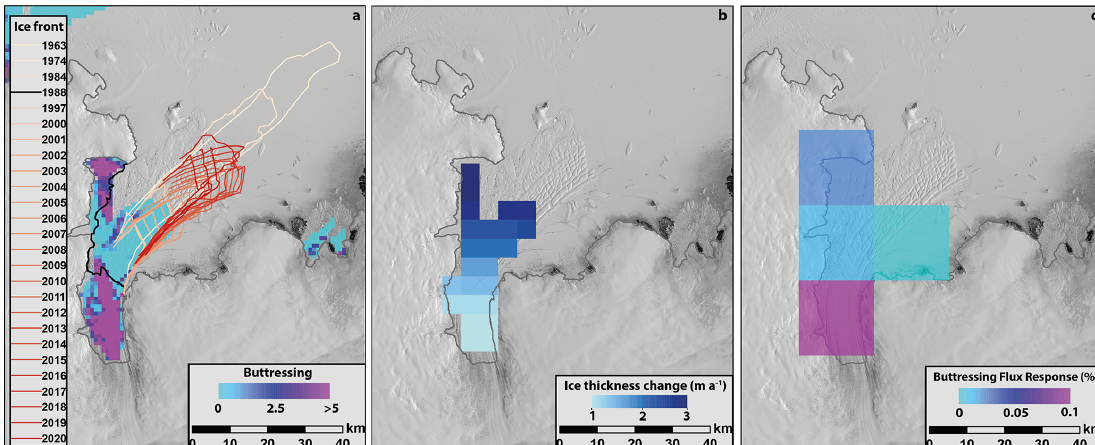
Figure 5. (a) Simulated maximum buttressing potential of the Shirase ice tongue (Durand et al., 2016). Light blues mean the ice is passive, and purples mean the floating ice is dynamically important. Note how the ice tongue conglomerate is not important for buttressing, but parts of the inner shelf are important. No dynamically important ice has calved over the past 57 years. (b) Ice tongue thickness change between 2003 and 2019 showing thickening of the Shirase ice tongue (Smith et al., 2020). (c) Simulated response of ice flux to thinning of floating ice in each grid cell by 1m (Reese et al., 2018); the constrained inner tongue near the grounding line is important for buttressing. Note that there is no change in ice tongue buttressing in response to observed changes in ice tongue extent, but increased buttressing is expected in response to observed ice tongue thickening. Landsat images are courtesy of the U.S. Geological